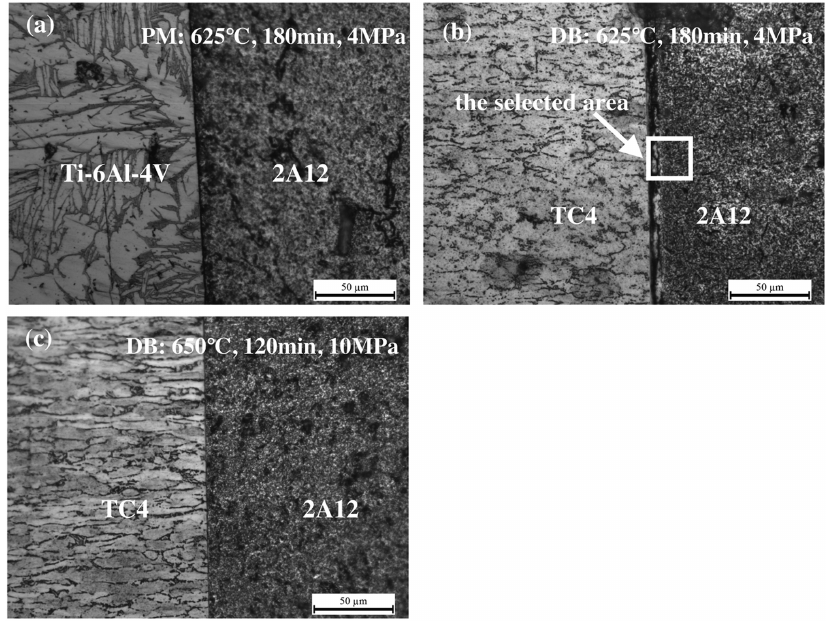
Figure 2: Optical micrographs in interface region of Ti/Al bonds obtained by different methods (a) P/M; (b) and (c) DB.